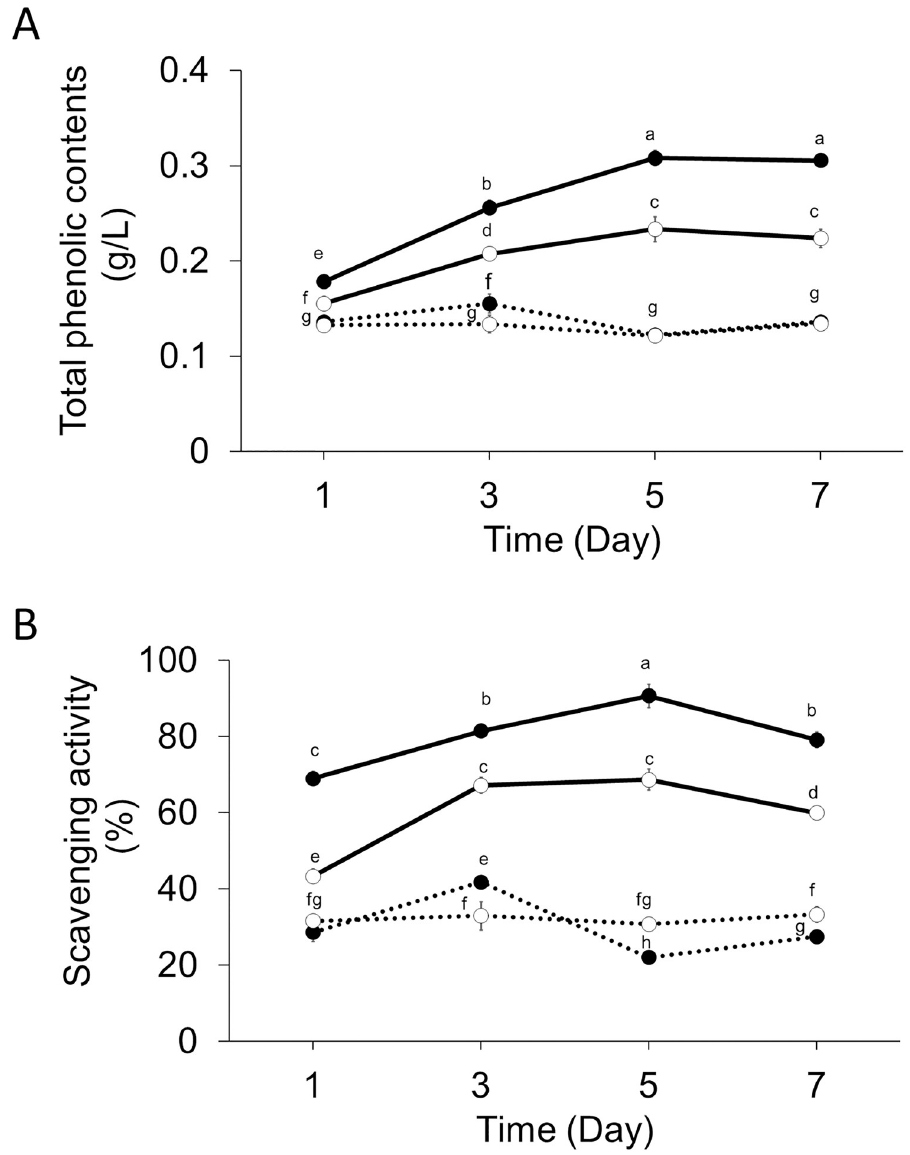
Fig 5. Total phenolic content and antioxidant activity of InK derived from the engineered strain. Total phenolic content of InK in cell-free broth of AoInK cultures grown at different cultivation times (A). Scavenging activity of InK (B) in cell-free broth of AoInK cultures grown at different cultivation times. Smooth and dotted lines indicate the cultures of AoInK and recipient strains, respectively. Black circles represent 1% Tween-treated cultures; white circles represent untreated cultures. Letters above the circles indicate the significant differences in measured values ( p < 0.05).